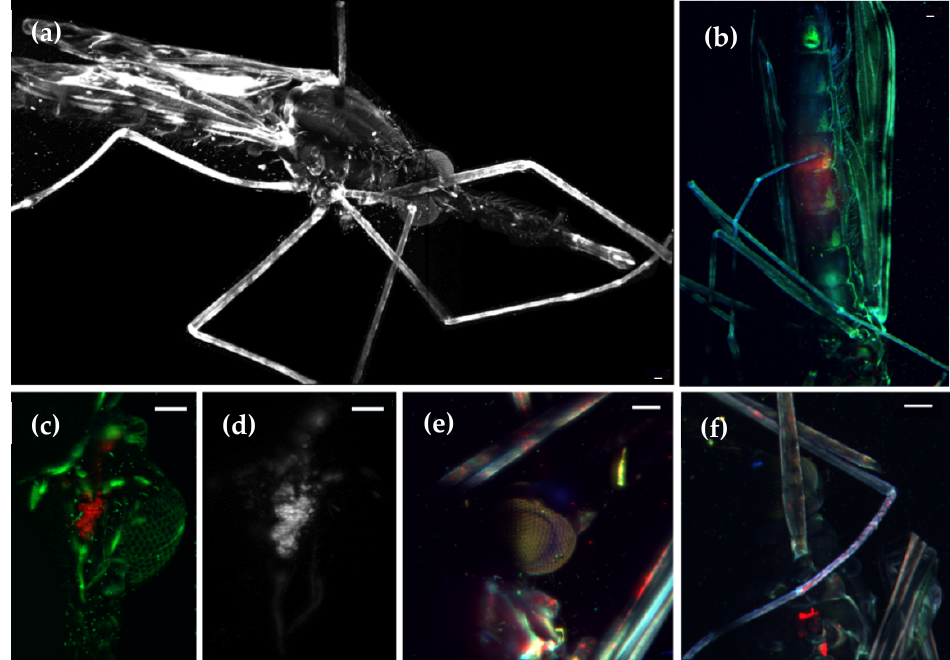
Figure 3. Maximum intensity projection of the auto-fluorescence from Anopheles stephensi mosquitoes. ( a ) Whole mosquito anatomy. This image consists of the stitching of two 3D stacks obtained with a 4× objective, 488 nm laser illumination and long pass filter. See also Video S2. ( b ) Mosquito’s midgut region, imaged at 4× with two channels (GFP in red, auto-fluorescence in green). Specific regions were imaged at higher resolution with a 10× objective: ( c ) salivary gland; ( d ) GFP signal in the salivary gland indicating a high concentration of sporozoites; ( e ) head and ( f ) front legs. Sporozoites appear in in red. Scale bar: 100 µm.